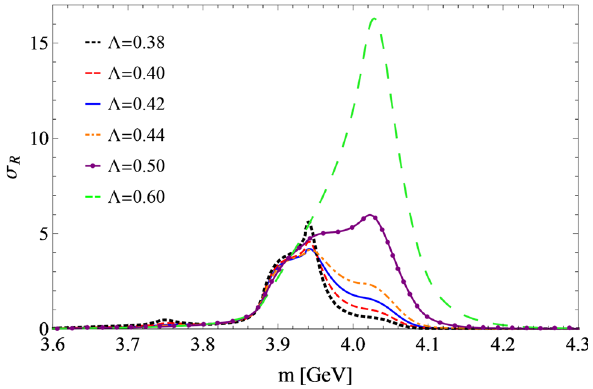
Fig. 6 Study of the cross-section ratio of Eq. (41) upon changing the value of cutoff parameter Table 2 Partial decay widths on-shell for both types of form factor and different values of (cid:11) parameter (cid:11)